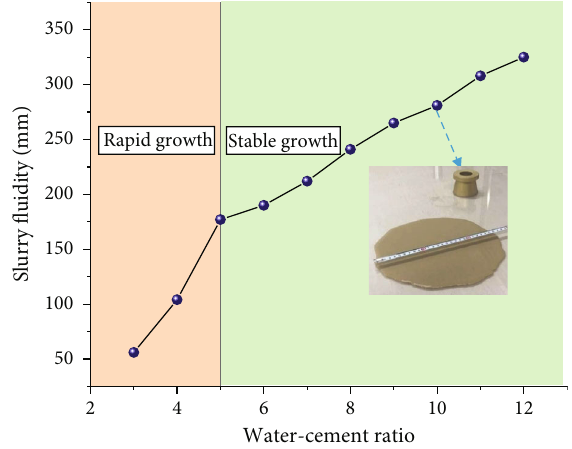
Figure 3: Relations between the slurry fl uidity and water-cement ratio.